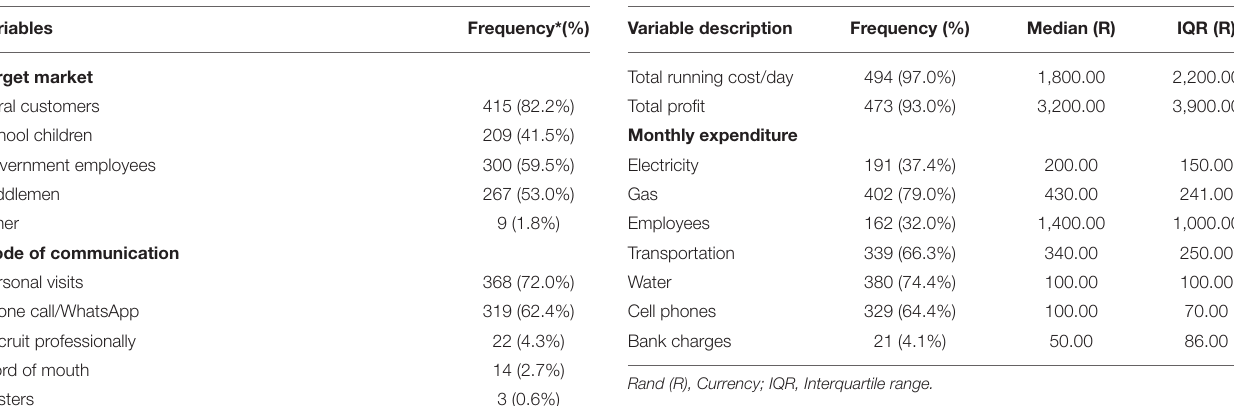
TABLE 6 | Street food vending target market.